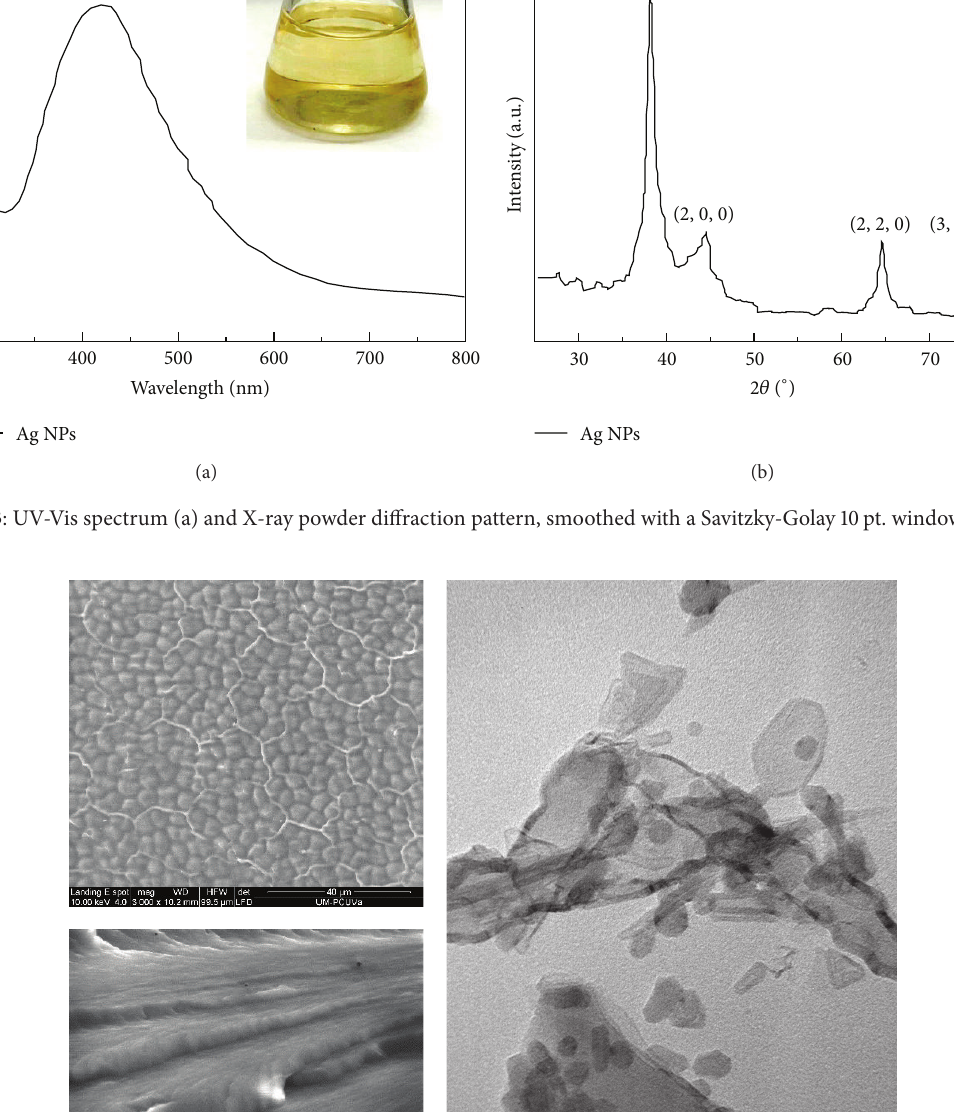
growth took place up to the 7th day, in which there was also a slope change and the growth started to be less